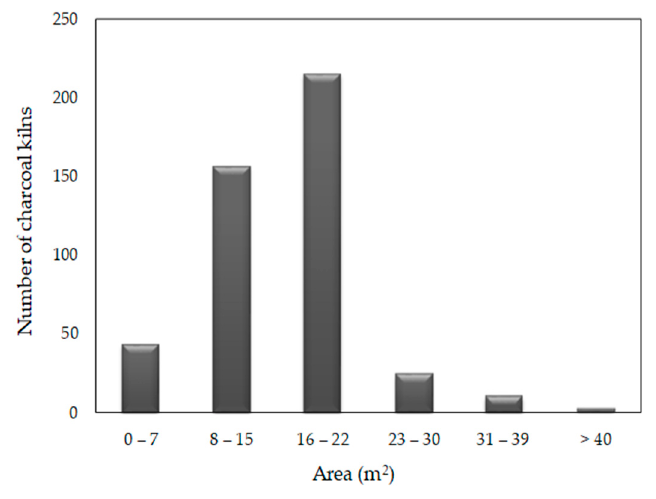
Figure 4. Number of kilns by cross-sectional